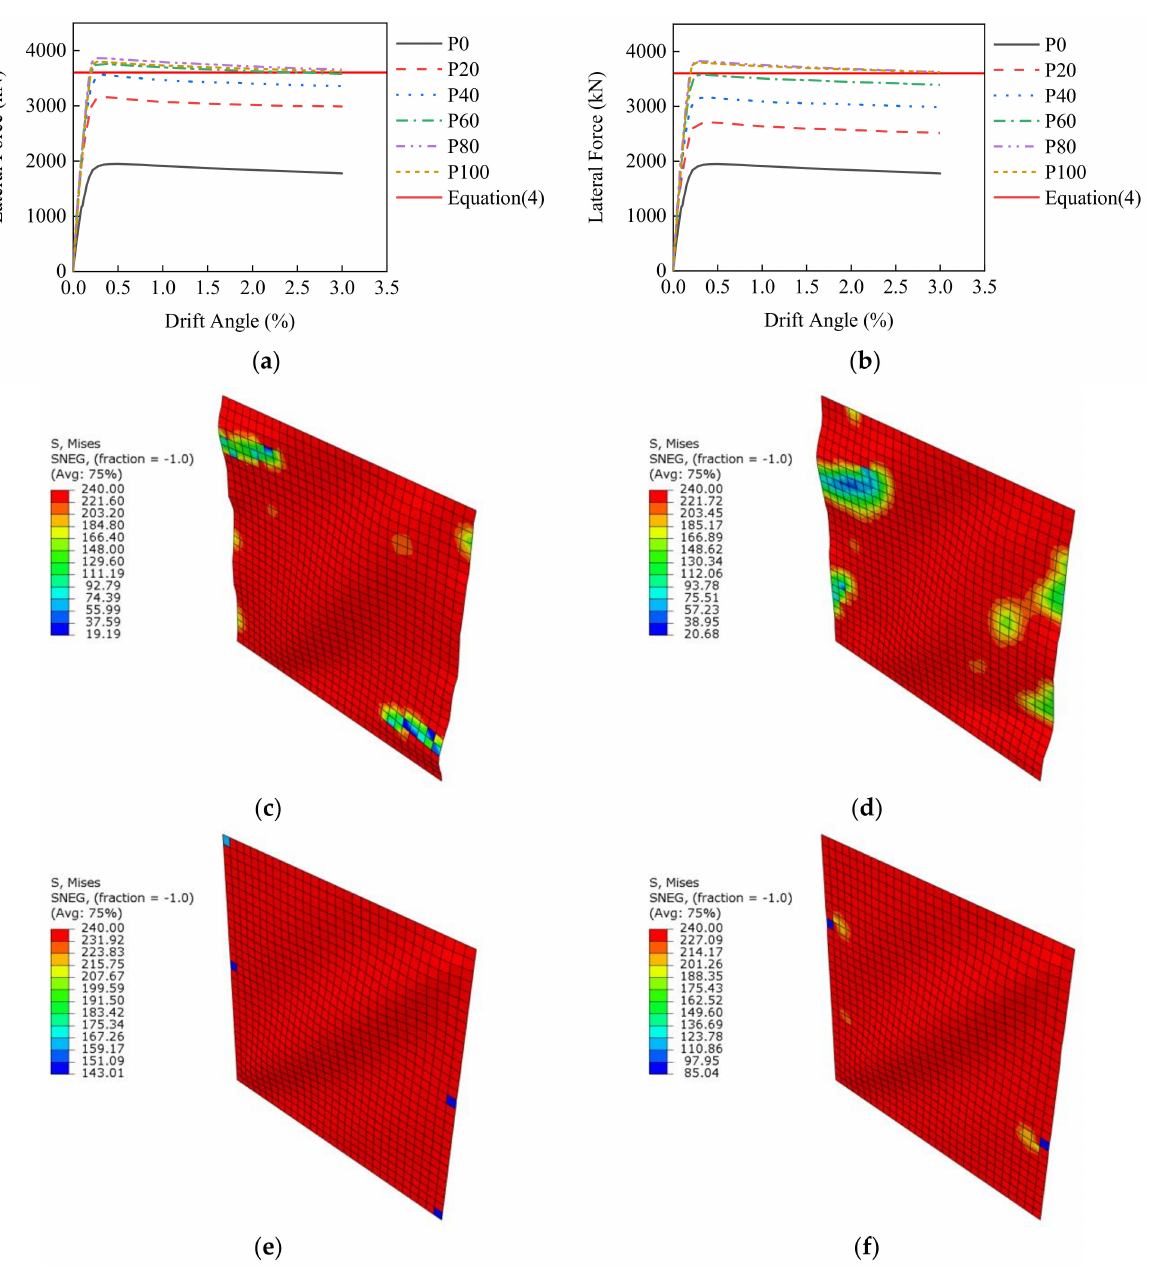
Figure 9. Load–displacement curves and stress distributions at 3% drift of S2 and S2R models: ( a ) S2; ( b ) S2R; ( c ) S2-P20; ( d ) S2R-P20; ( e ) S2-P80; ( f )